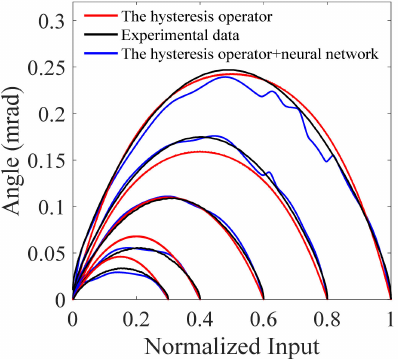
Figure 14. Illustration of the complex nonlinearity of fast steering mirrors.